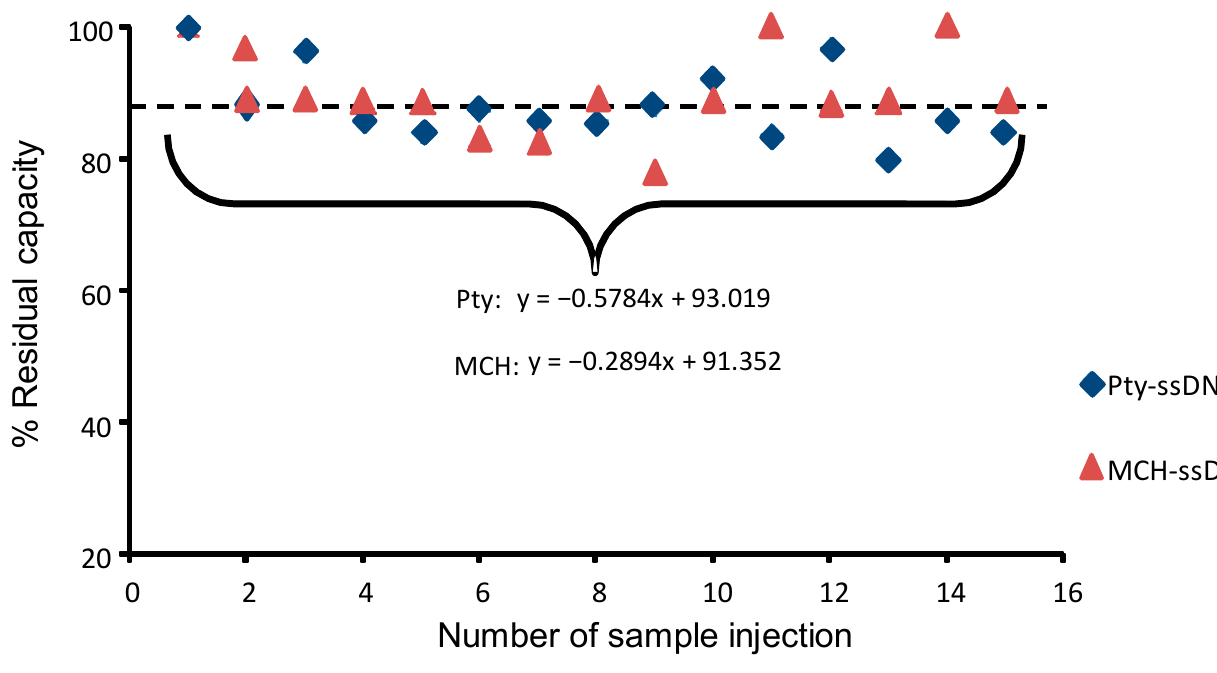
Figure 8. Reusability of Pty-ssDNA- and MCH-ssDNA-modified sensor chips. A total of 250 µ L of a 10 − 9 M target ssDNA was applied 15 times on each sensor chip with a regeneration step between each individual assay. Symbols represent averages of triplicate data collected from CapSenze™ Biosystem.